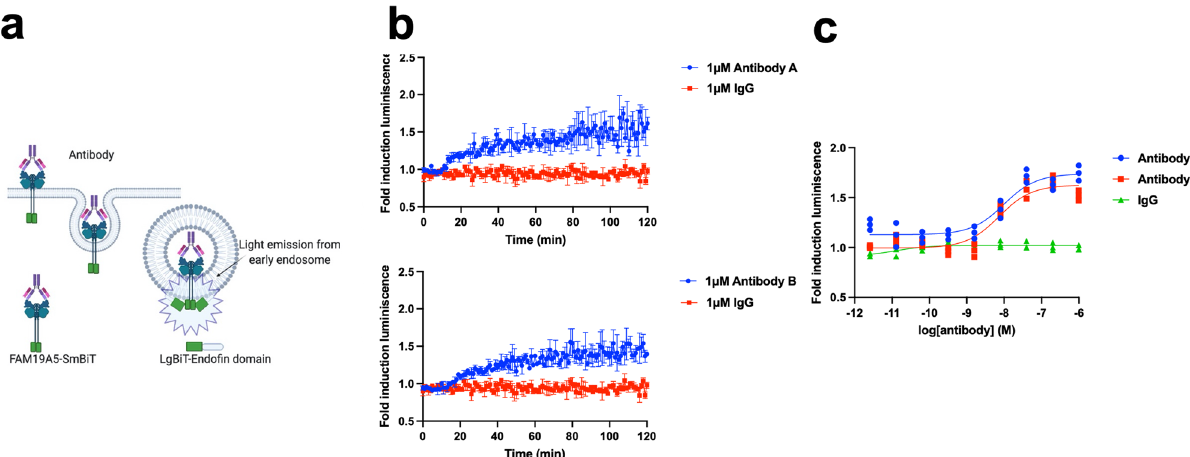
Fig. 6 Membrane protein internalization by binding with two monoclonal antibodies. a Schematic of a membrane protein being internalized by the binding with an antibody via early endosomes. b The membrane protein (FAM19A5 Isoform II) being internalized when cells expressing FAM19A5 Isoform II were treated with 10 and 100 nM of two antibodies (these antibodies are currently under development). 1 µ M IgG antibody was used as a control. The top panel shows antibody A and the bottom panel shows antibody B. c Dose – response curves for both antibodies. The corresponding EC50 value for antibody A was 7.69 ± 0.30 nM ( Z ’ factor of 0.63) and for antibody B ( Z ’ factor of 0.64) was 8.15 ± 0.43 nM. The arrow indicates the time when the cells were treated with the virus. The results are expressed as mean ± s.e.m. of three experiments performed in triplicate; each triplicate was averaged before calculating the s.e.m.